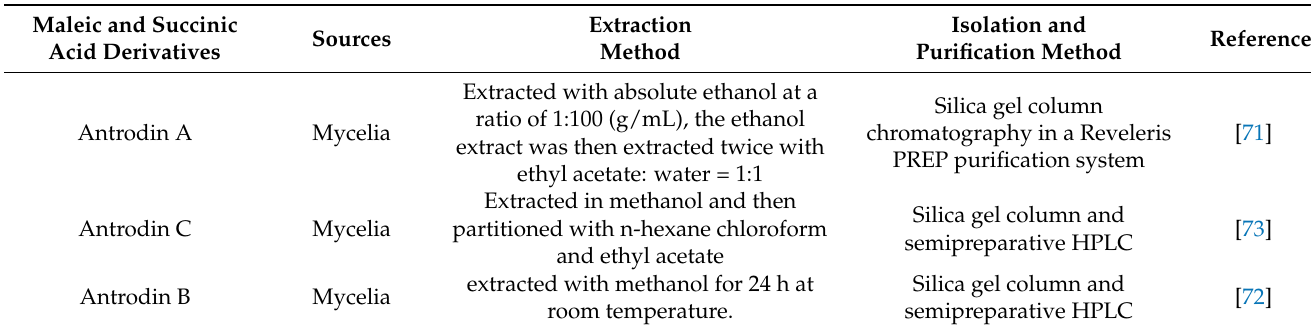
Table 4. Preparation procedures of maleic and succinic acid derivatives from A. cinnamomea in recent